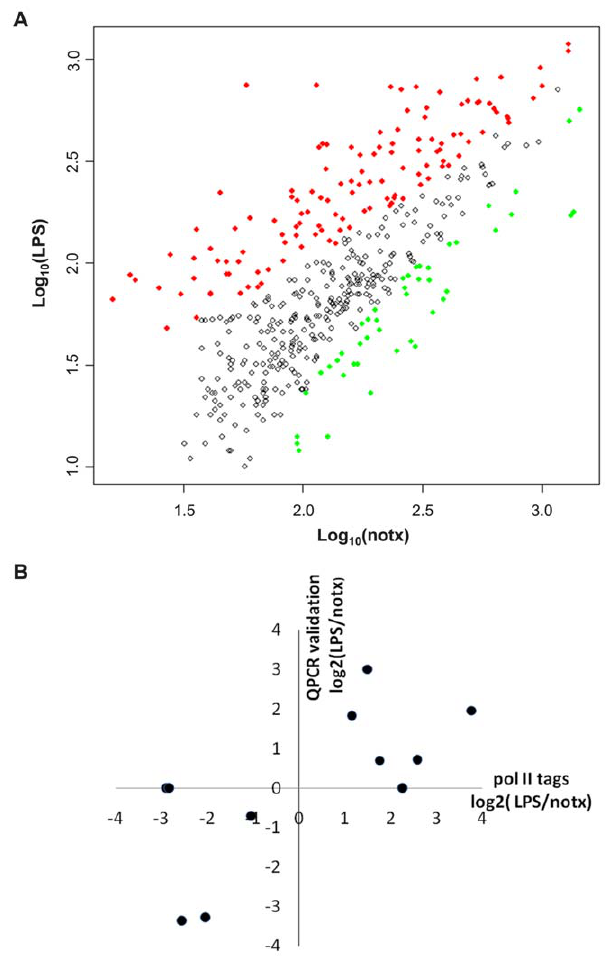
Figure 4. Effect of LPS on lincRNAs. A: differentially regulated lincRNAs by LPS. Due to the difference in tags between the LPS vs. no- treatment conditions, tag counts under the no-treatment condition are first normalized by a linear regression, and then tested for difference as described in Methods. Data plotted are the log10 transformation of the original tag counts in LPS treatment vs. the log10 transformation of the original tag counts in LPS treatment. Red data points (126) denote up- regulation and green data points (45) denote down-regulation. B: experimental validation of 11 lincRNAs. Data are plotted as log2 transformation of fold change on predicted exons by QPCR experiments vs. log2 transformation of fold change in Pol II tag counts by QPCR experiments. The lincRNAs that are under-detectable in QPCR are assigned to have y-values of 0.